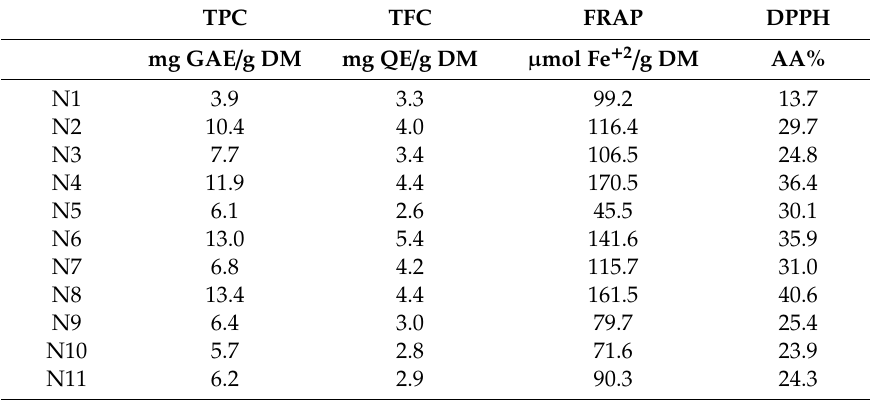
Table 4. Responses for fractional factorial IV resolution design.